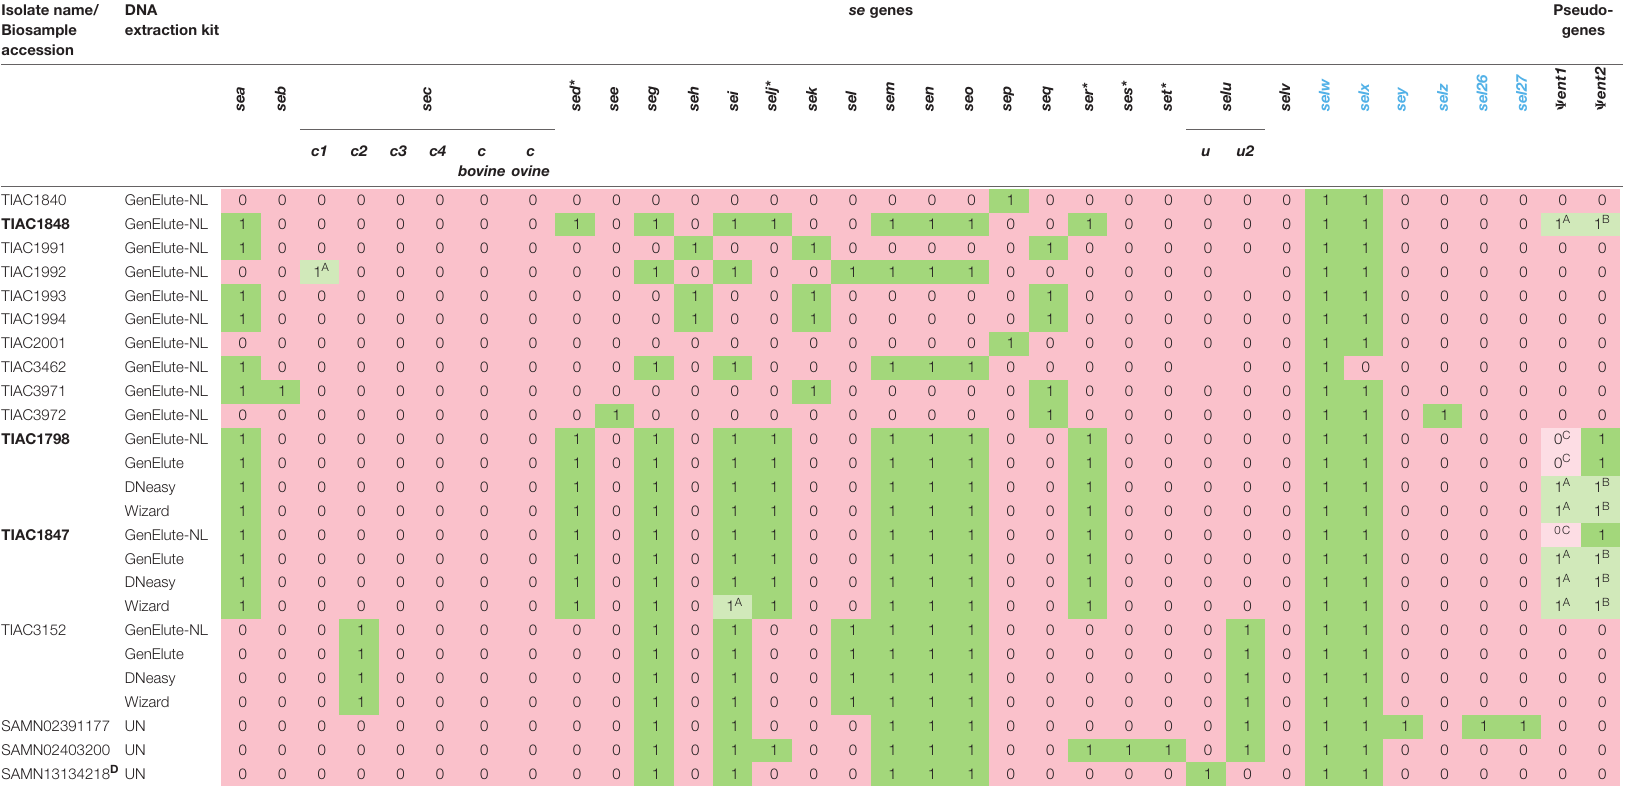
TABLE 3 | WGS-based se gene profile of the selected in-house isolates and influence of the DNA extraction kits on se gene profiling. Isolate name/